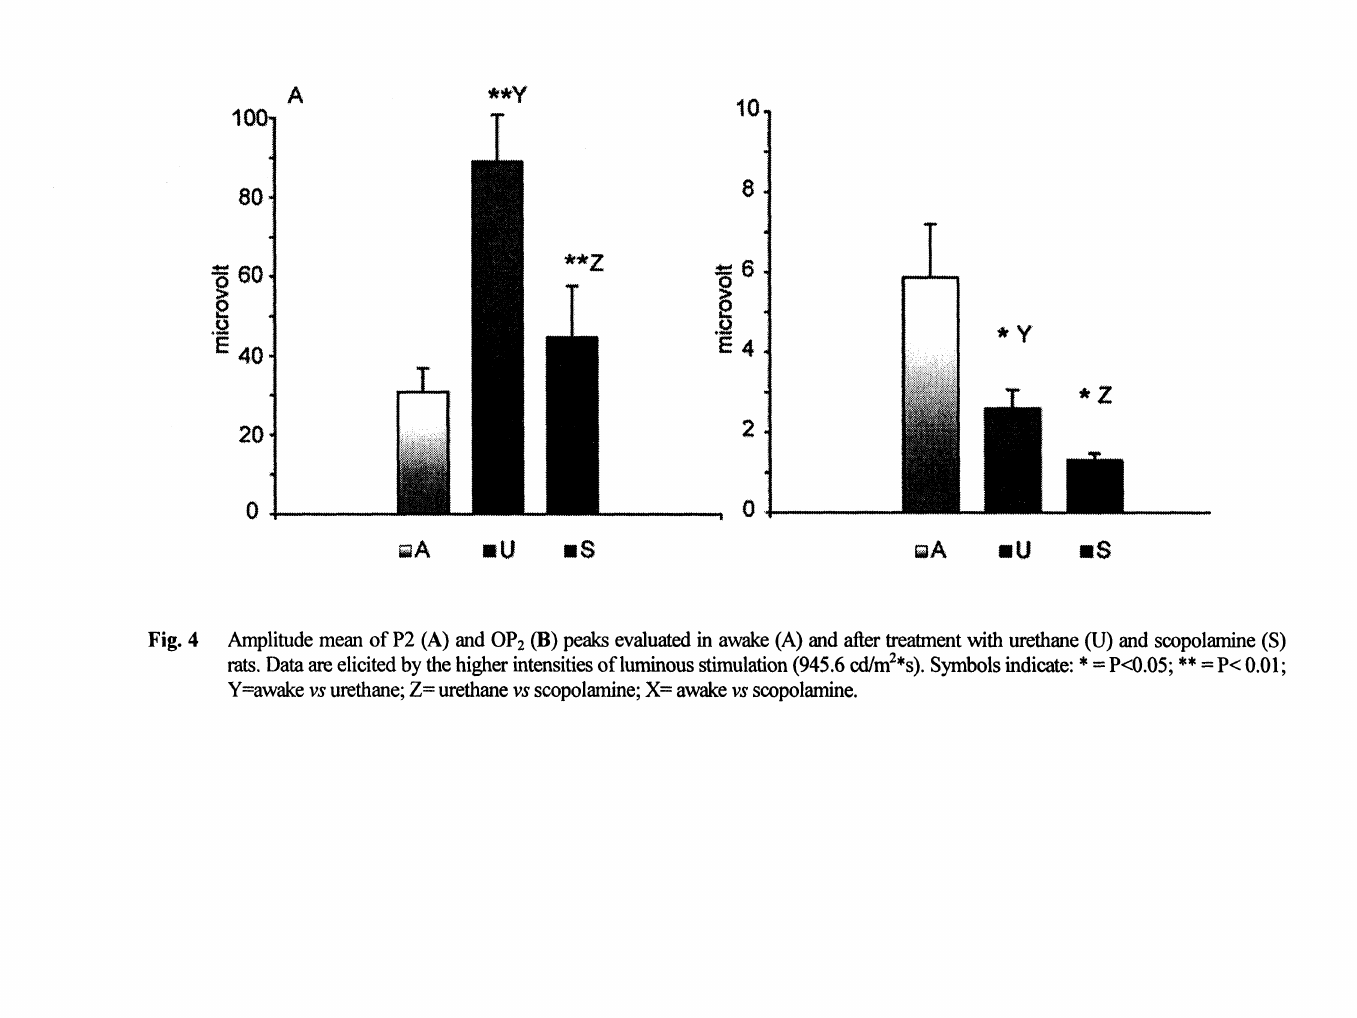
P2 OP2 b2 02 awake m urethane Latency mean of the different peaks (P2, OP2, b2 and 02) evaluated in awake rat and atter treatment with urethane and Fig. 3 scopolamine. Data are elicited by the lower intensities of luminous stimulation (236.4 mcd/m2*s). Symbols indicate: